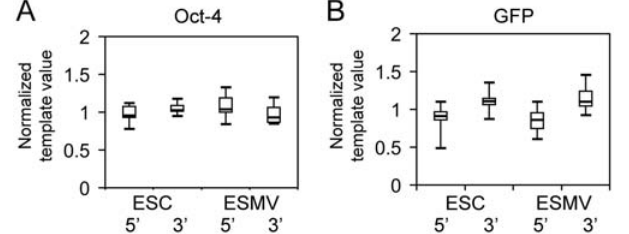
Figure 4. The RNA in ESMVs is not degraded. Real time quantitative RT-PCR was used to measure the level of degradation of oct-4 and GFP mRNAs in ESMVs by comparing the 5 9 and 3 9 amplicon ratios of these transcripts in ESMVs with those in ESCs. Significant levels of degradation were not detected with either transcript. (A) Box plot of normalized 5 9 and 3 9 template values for oct-4 mRNA in ESCs and ESMVs (n=9). (B) Box plot of normalized 5 9 and 3 9 template values for GFP mRNA in ESCs and ESMVs (n=12). The boxed area represents the mean 6 quartile and the whiskers extend out to the minimum and maximum values. Bootstrap t-tests were performed to compare the 5 9 :3 9 ratios for each transcript in ESCs and ESMVs. No significant difference was detected between the ESC group and ESMV group for either transcript ( p . 0.1).